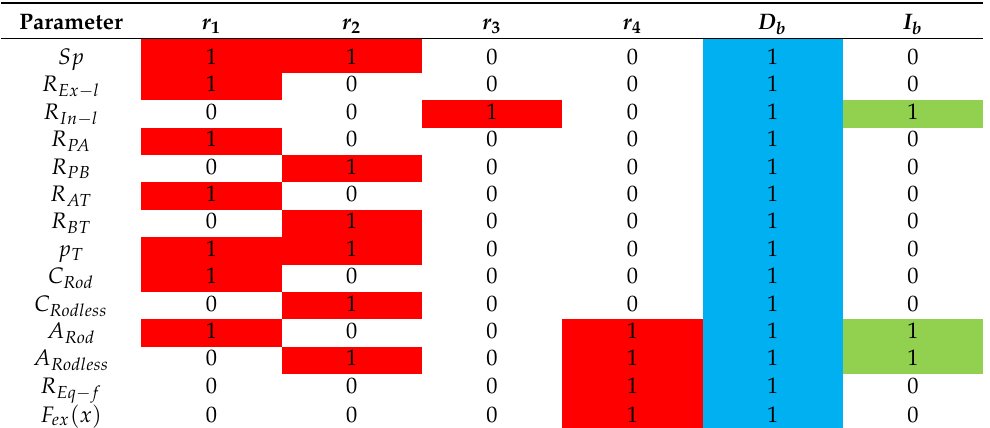
Table 4. Fault signature matrix of landing gear R/E hydraulic